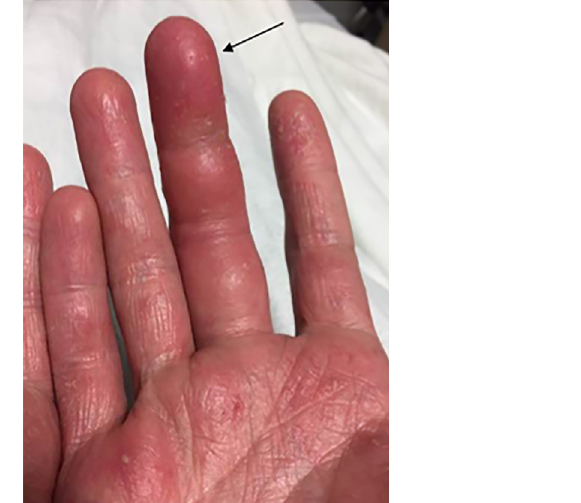
Image 1. Palmar aspect of the patient’s right hand. There is erythema and swelling (black arrow) of the right middle finger held in slight flexion. An associated scaly eczematous skin eruption is shown.